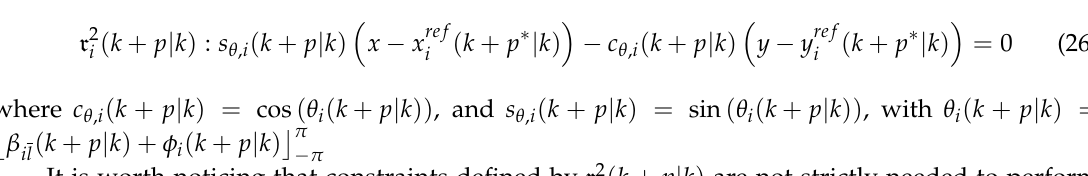
and r 2 define the admissible region for the i i